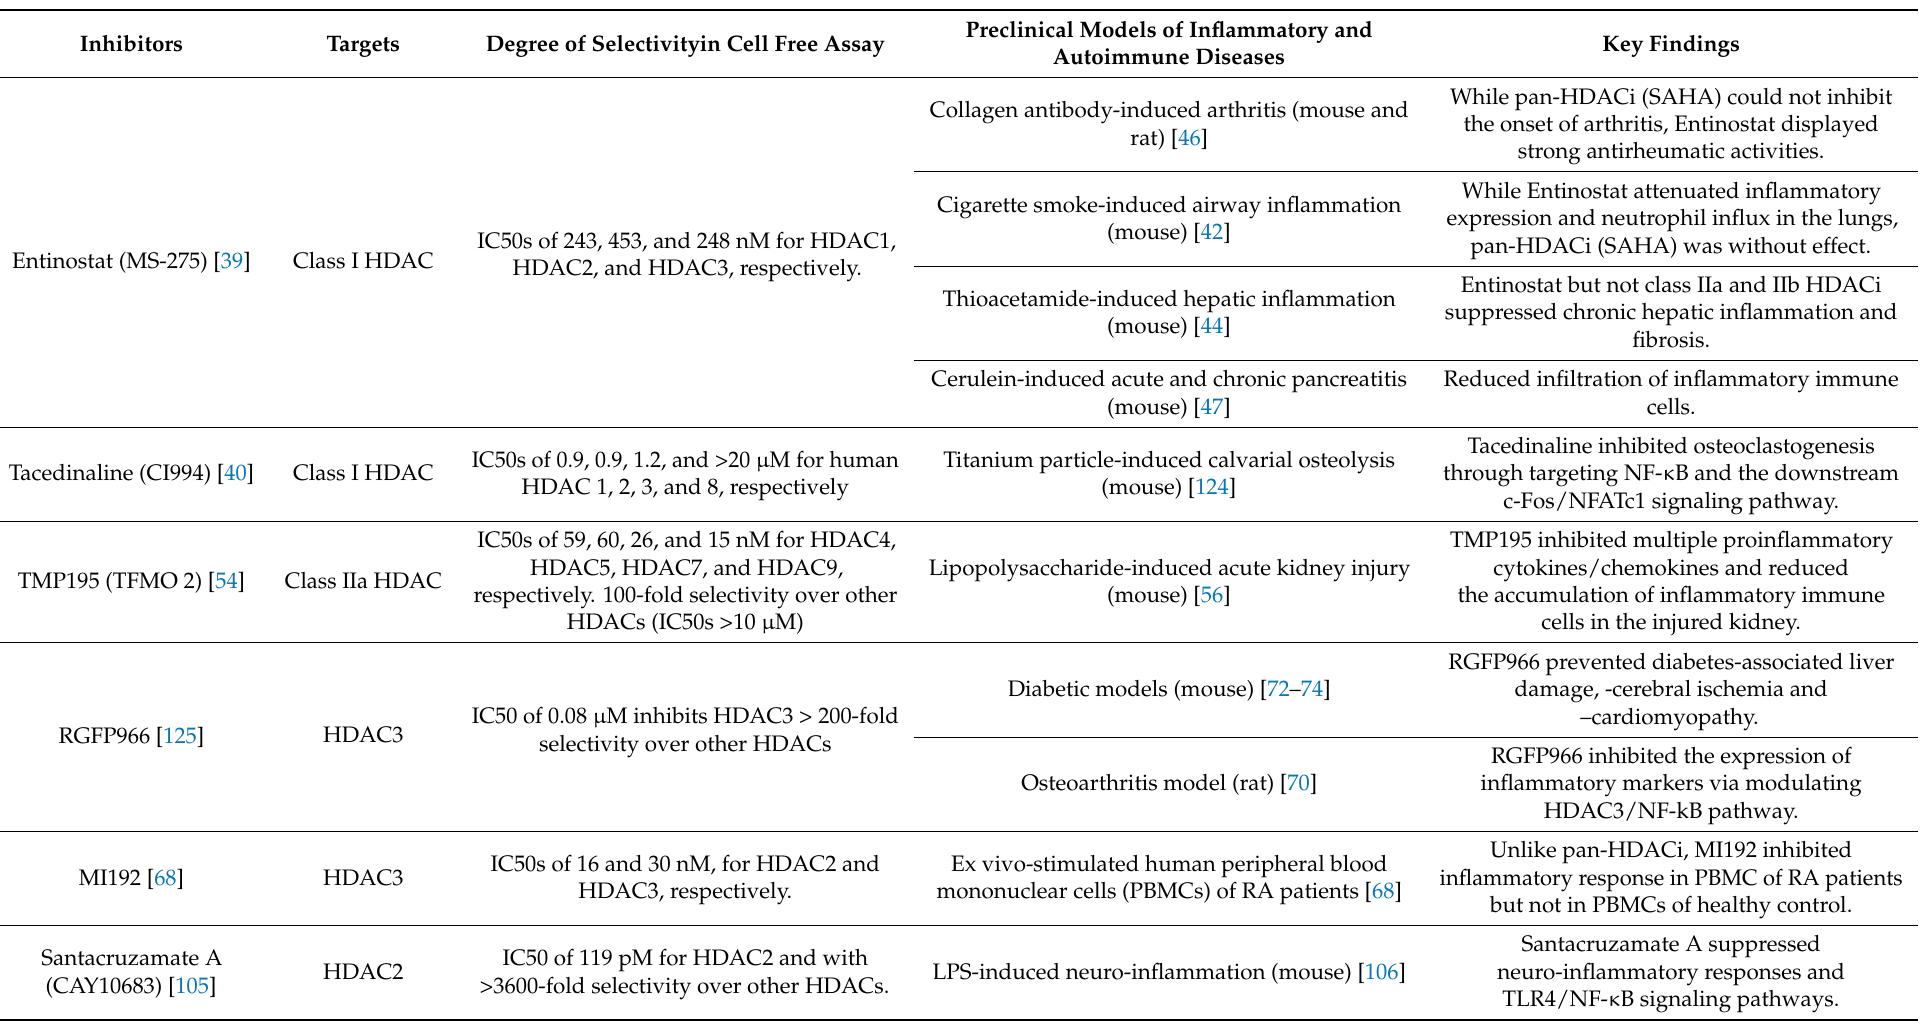
Table 1. Summary of some of the main tested selective inhibitors of HDACs and BCPs in ex vivo and in vivo models of inflammatory and autoimmune